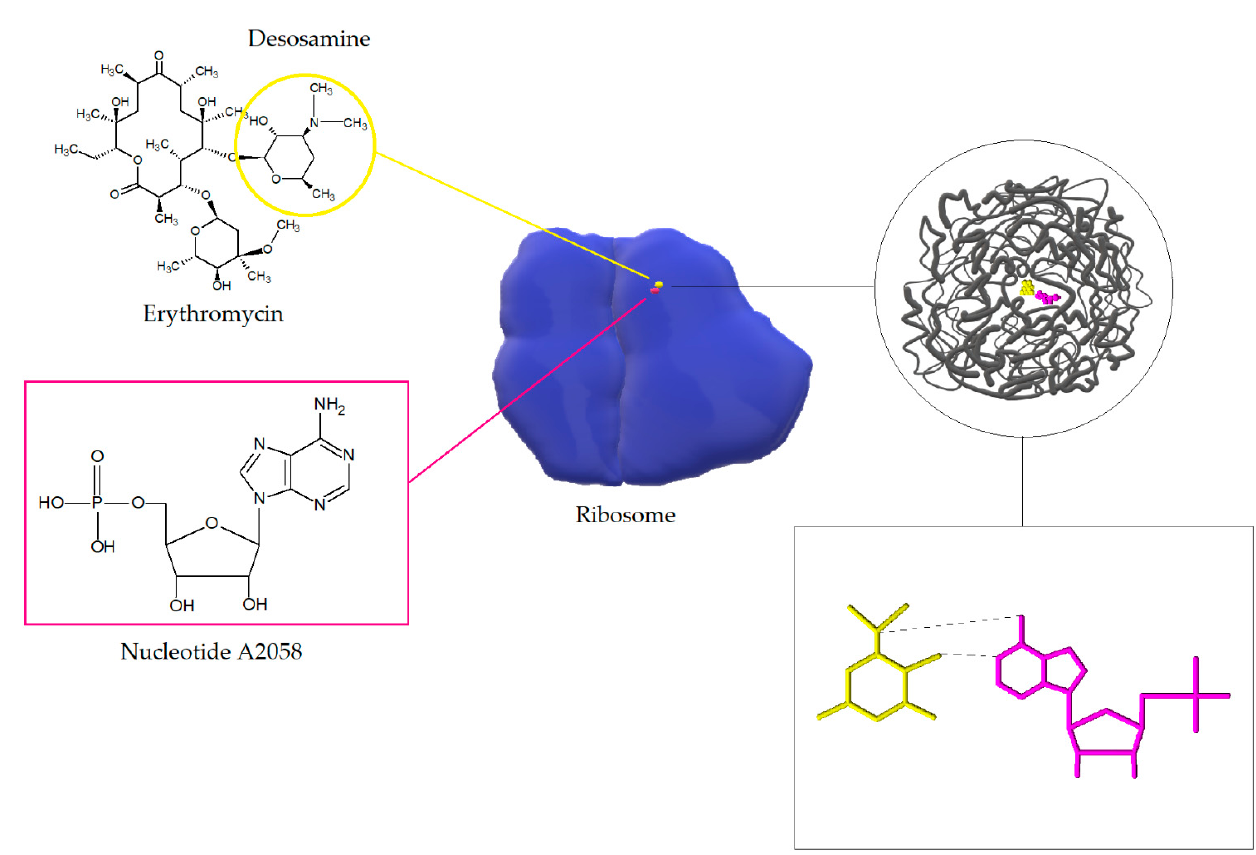
Figure 5. Interaction of macrolide (erythromycin) with 23S RNA nucleotide A2058. The figure shows the ribosome model (blue) and the model of the spatial arrangement of the exit tunnel (gray) with erythromycin (yellow) and nucleotides (pink) involved in the internalization of the antibiotic. After internalization of the macrolide with the binding site on the 50S ribosome subunit a hydrogen bond is formed between 2-OH group of desosamine and N1 in A2058 in NPET [52,53].